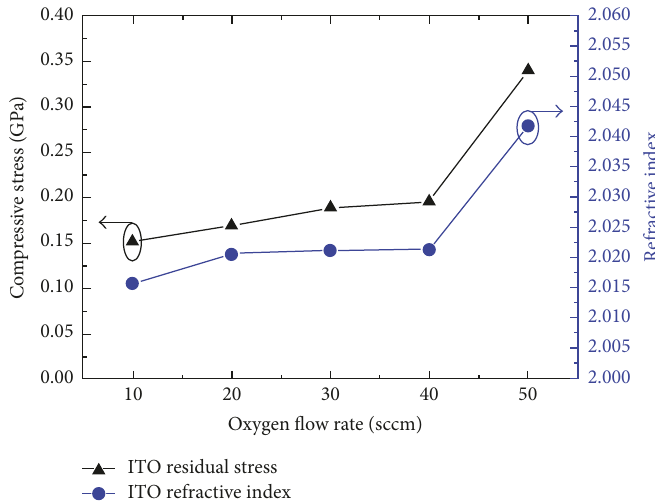
Figure 6: Residual stress and refractive index of ITO thin films as a function of oxygen flow